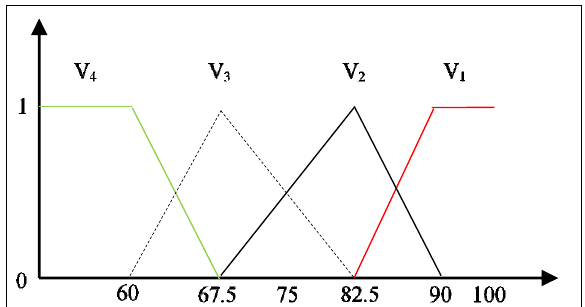
Figure 1. Linear membership function